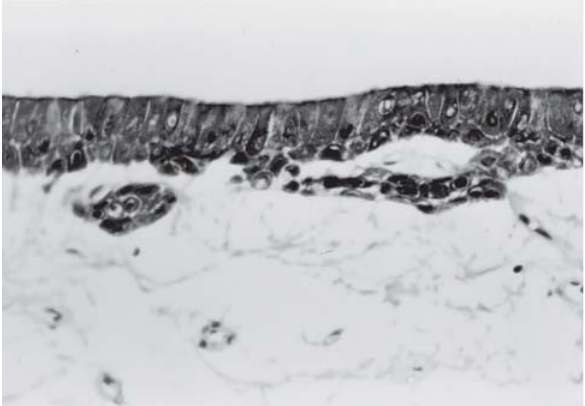
FIGURE 3- Adenomatoid odontogenic tumor: laminin in the intercellular deposits and luminal surface of adenomatoid structures. X200